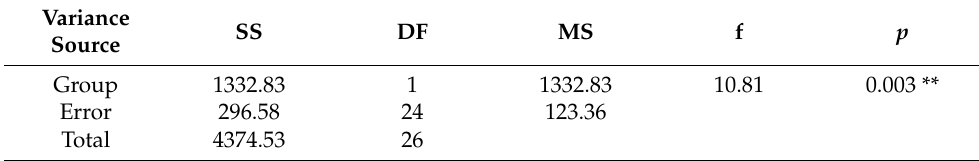
Table 7. ANCOVA results of the low-achievement students between the two groups. Variance